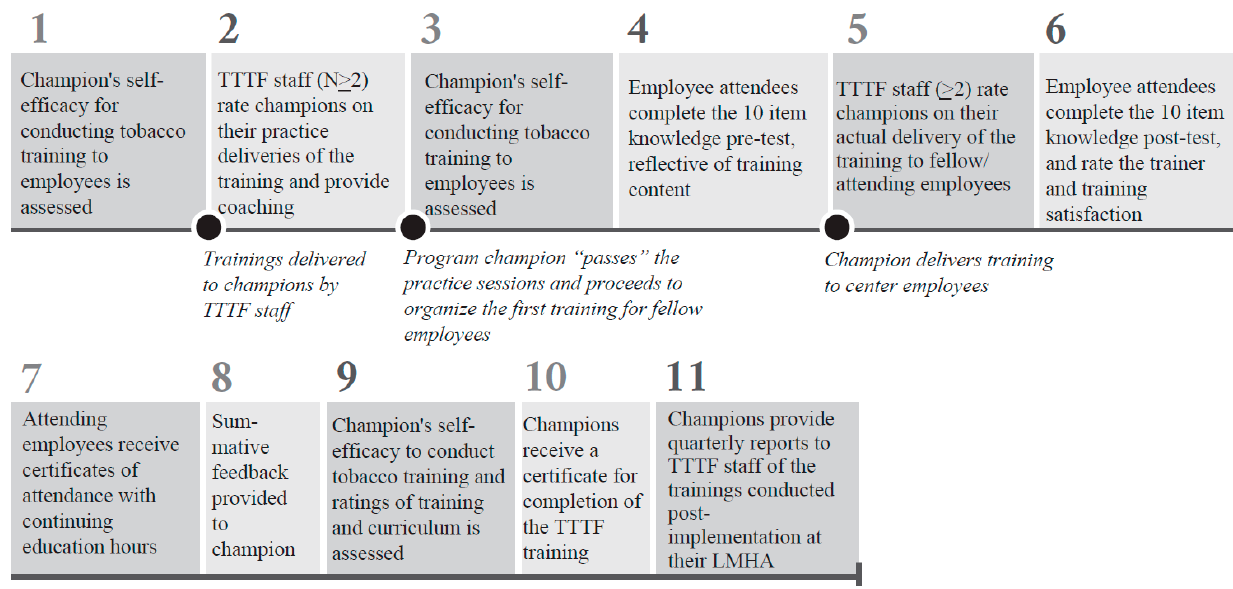
Figure 1. This infographic summarizes the implementation steps of the train-the-trainer program. Important events have been marked in between certain steps. TTTF = Taking Texas Tobacco Free.